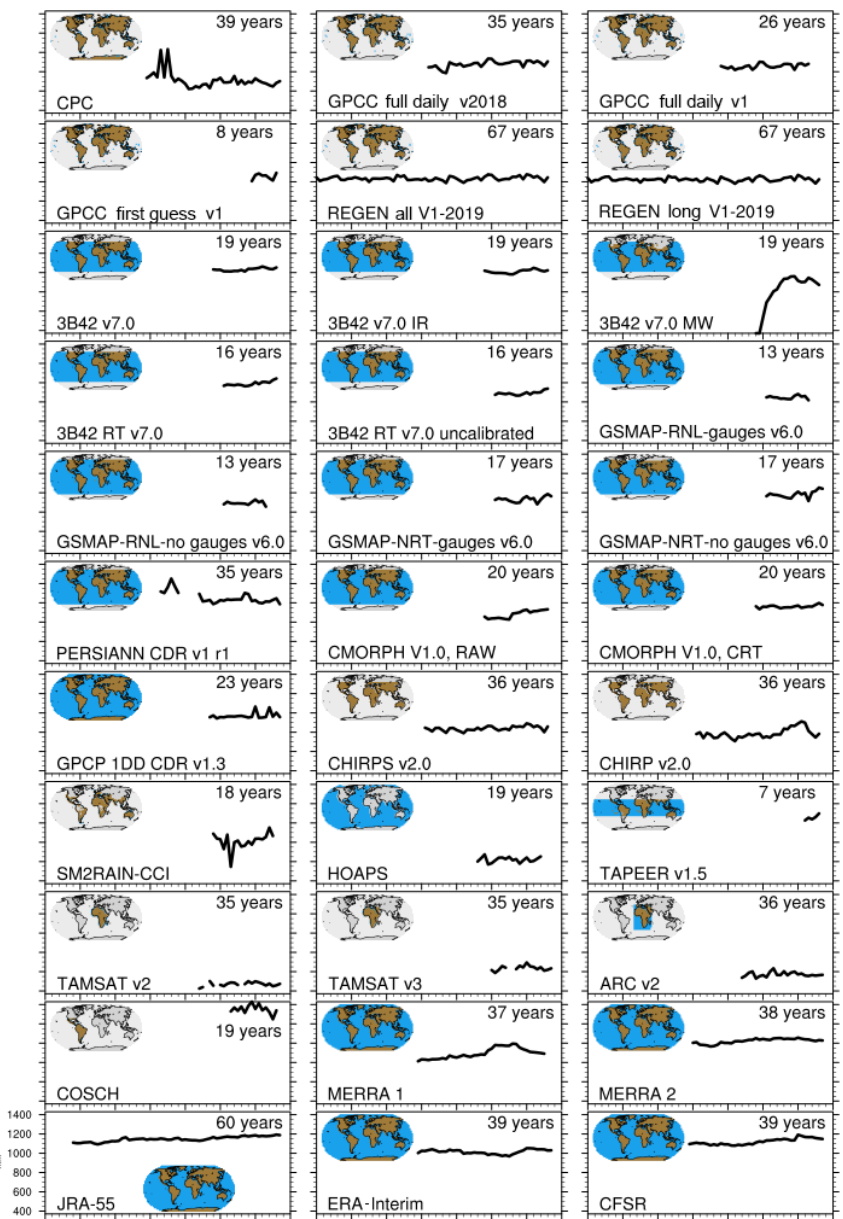
Figure 1. Time series of annual total daily precipitation in millimeters (mm) averaged over each dataset domain (regional or global, land or ocean, or both) as shown on the embedded maps in the panels. The name of the dataset and number of years available are indicated in each panel. Datasets are organized by order of appearance in Tables 1, 2 and